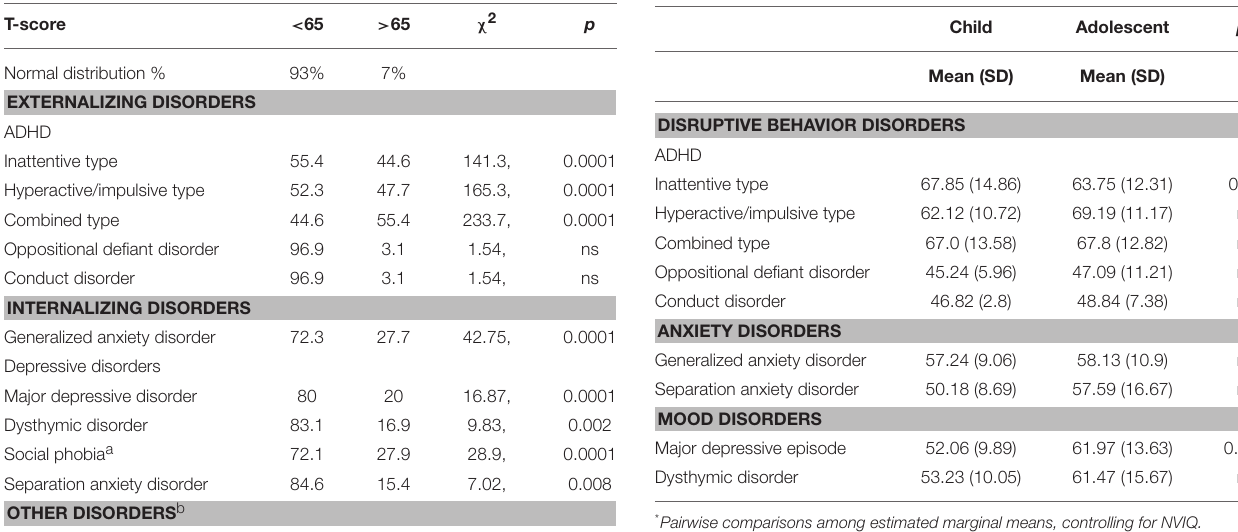
TABLE 4 | Mean (and Standard Deviations) of CASI-5 severity scores (T-scores) for symptom classifications.